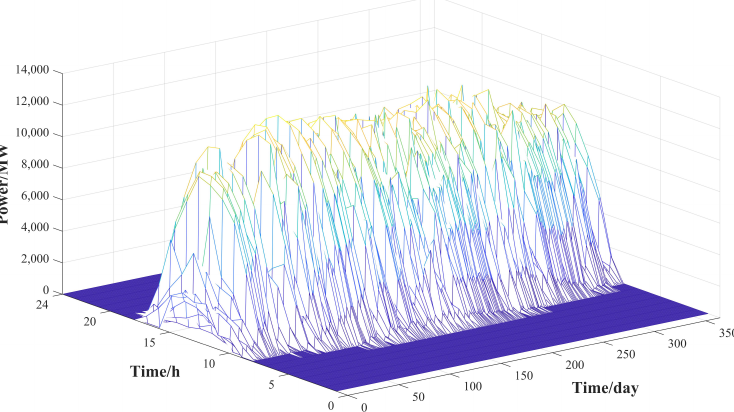
Figure 6. The annual PV power output curve in a certain